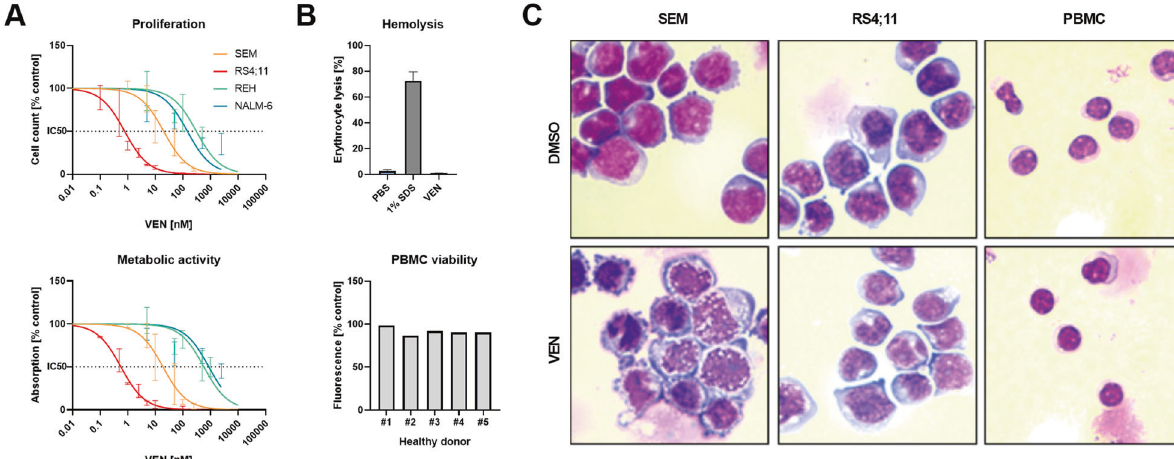
Fig. 1 In fl uence of VEN on healthy cells and leukemic blasts. A Dose-response curves (nonlinear regression, curve fi t) of cell lines SEM, RS4;11, REH, and NALM-6 were incubated with increasing concentrations of VEN for 72 h. Proliferation and metabolic activity were assessed by trypan blue staining and WST-1 assay, respectively. Mean ± SD of 1 – 3 biological replicates. B Erythrocyte and PBMC cytotoxicity were evaluated by hemolysis and calcein-AM assay, respectively. The blood of fi ve healthy donors was used. Mean ± SD of three technical replicates. Hemolytic activity was assessed by hemoglobin release after 120 min incubation with 10 nM VEN or 1% SDS (positive control). For viability testing, PBMCs were incubated with 10 nM VEN or DMSO (control) for 24 h. C Cells were treated with 2.5 nM (RS4;11) or 10 nM (SEM, PBMCs) VEN for 48 h and subsequently spun onto microscopic slides and Pappenheim stained. Representative images of three independent biological replicates at 100x magni fi cation.